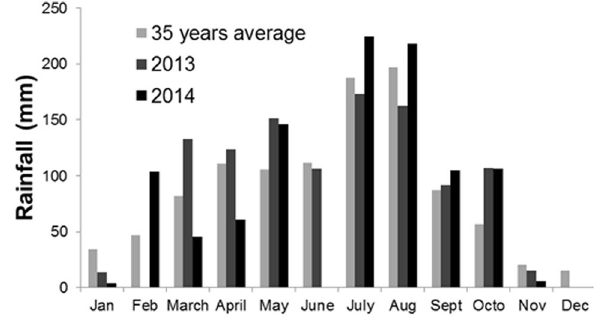
Experimental set‑up and procedure